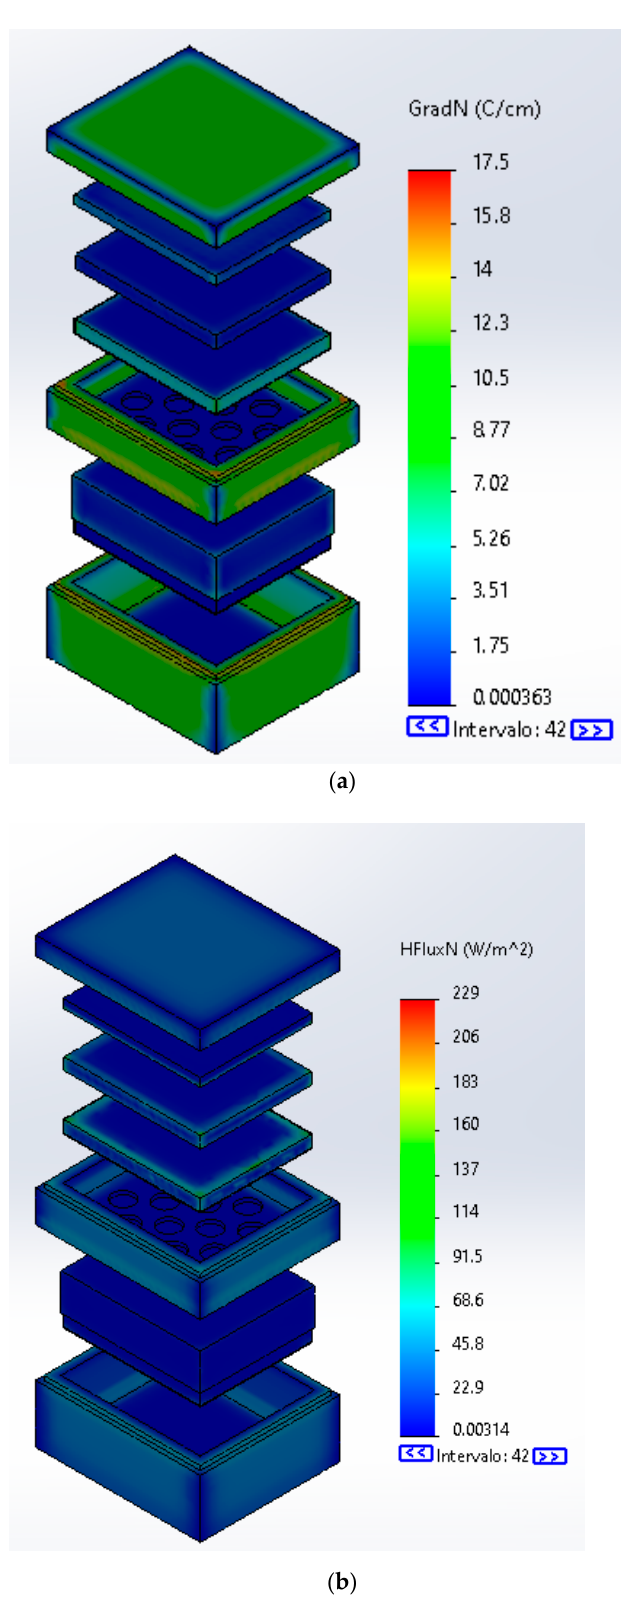
Figure 7. Isothermal box with PCM behavior ( a ) Gradient temperature ( b ) Heat Flux. Since the PCM of AA-100M can be used in temperatures between − 25 ◦ C to 14 ◦ C and according to the simulations manages to maintain a − 13 ◦ C environment for at least 7